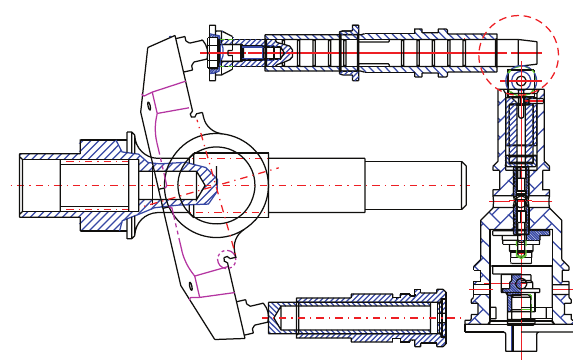
Figure 8: Schematic of VDAPP in the case of maximum flow rate.